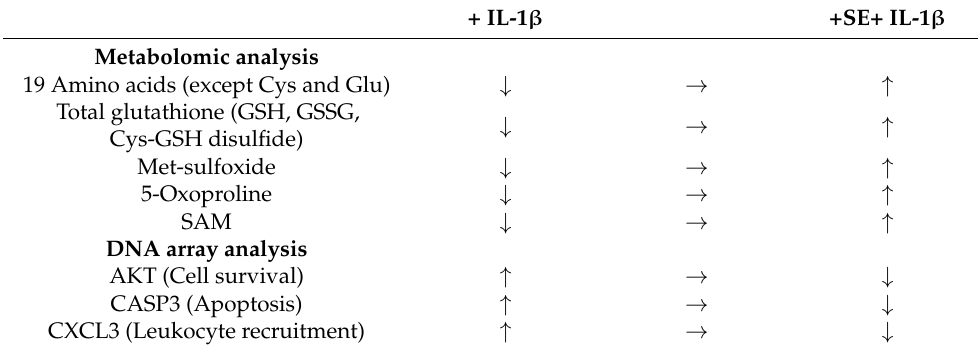
Table 3. Summary of anti-inflammatory action of SE against IL-1 β -treated HGF cells. + IL-1 β +SE+ IL-1 β Metabolomic